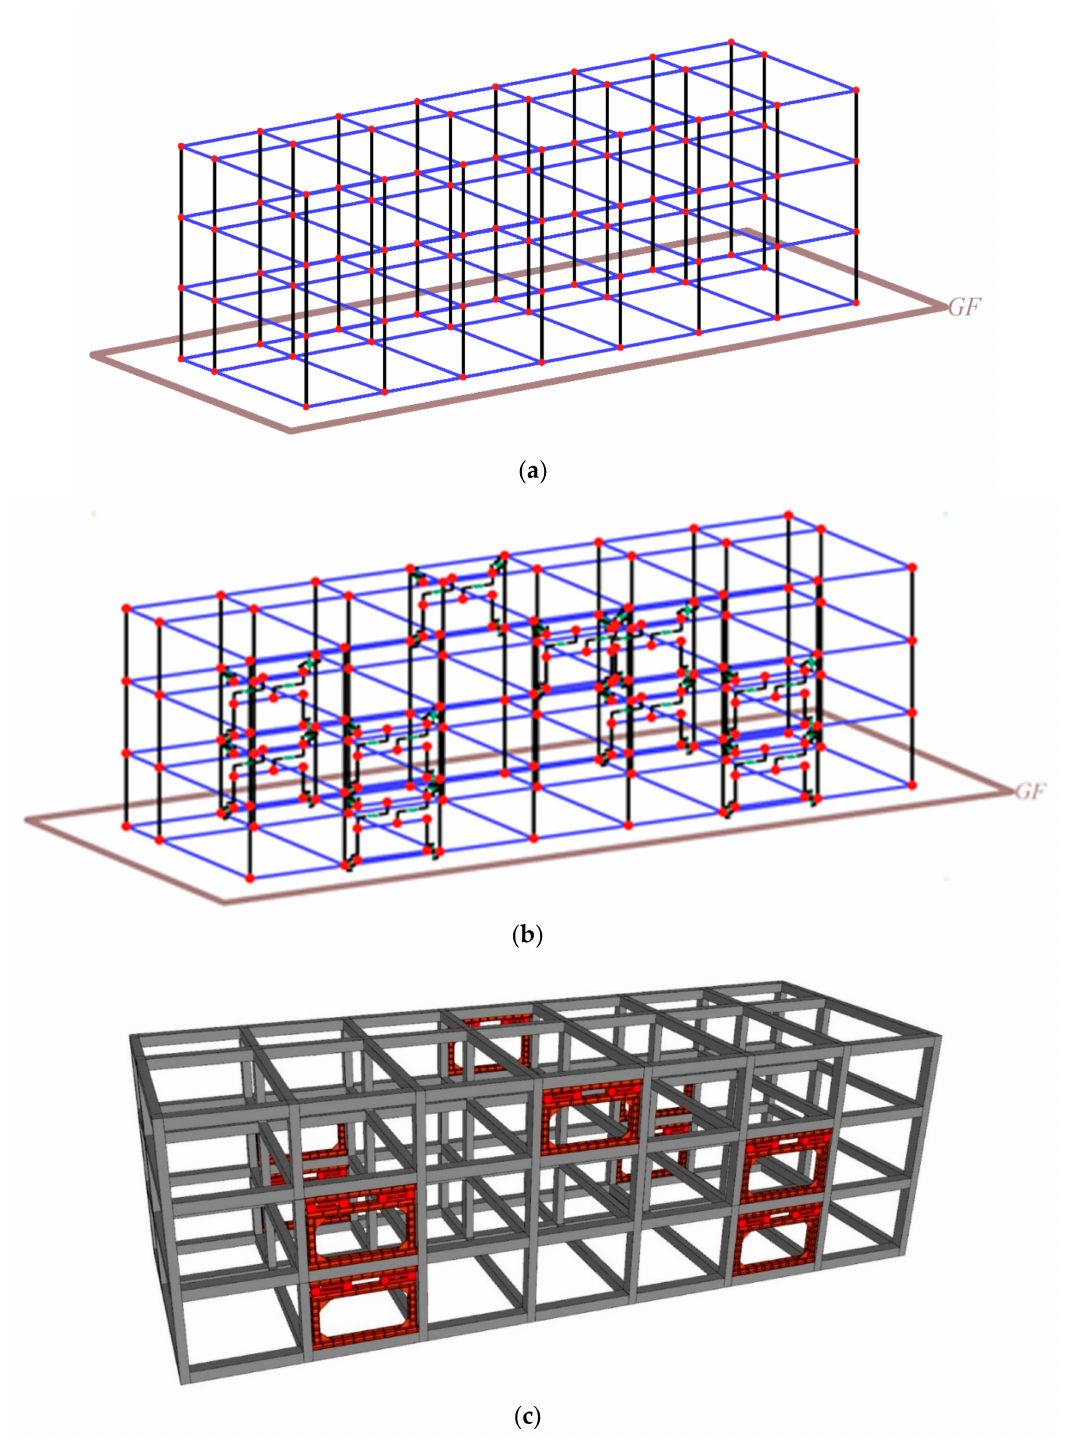
Figure 28. Analytical models and simulated frames of the target RC school building before and after reinforcement: ( a ) analytical model before seismic reinforcement, ( b ) analytical model after seismic reinforcement, and ( c ) simulated frame after seismic